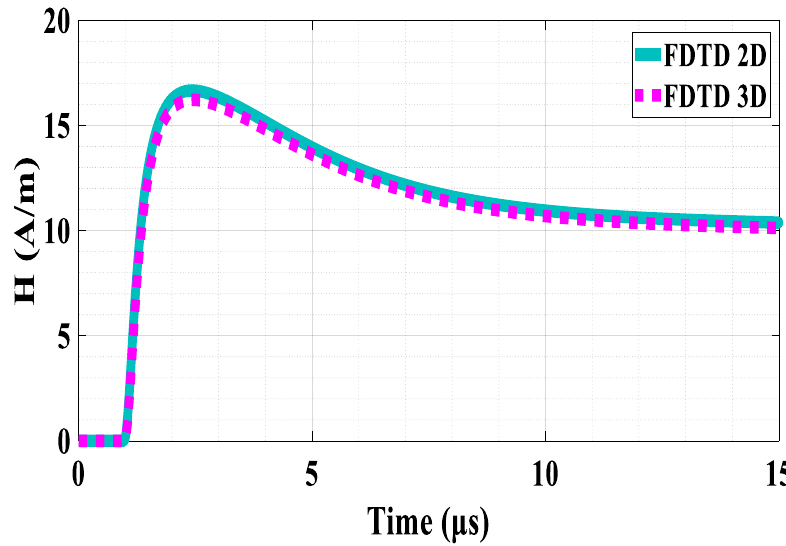
Figure 9. Horizontal magnetic field ( H y ) on a smooth ideal ground at observation point A. The height of the mountain is set at H m = 0 m. Results were calculated using the 2D-FDTD (solid line) and the 3D-FDTD (dashed line) methods.